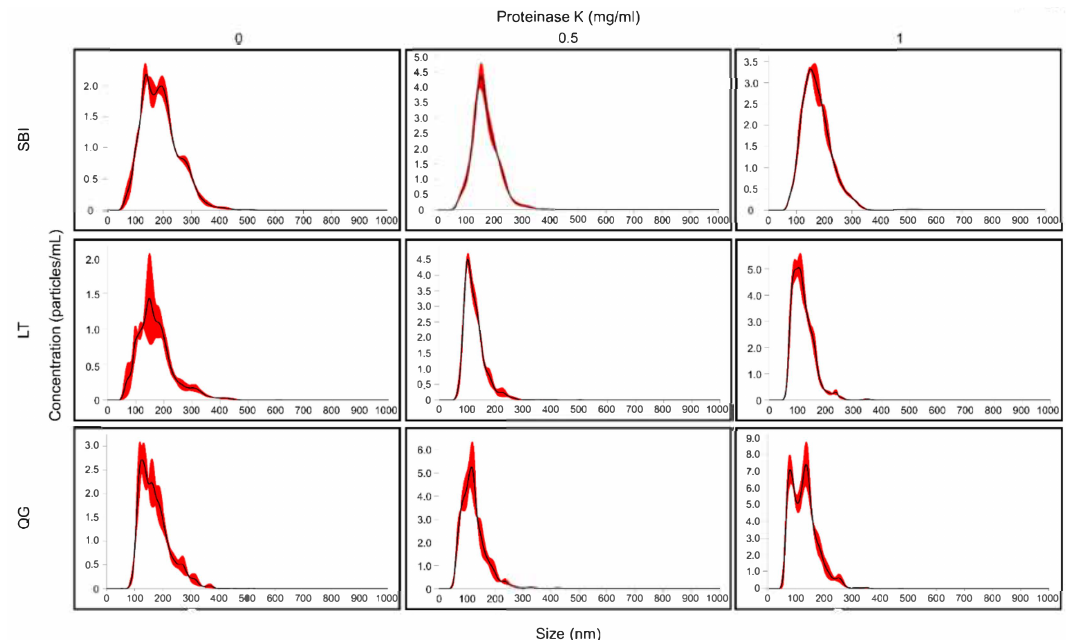
Figure 5. Size distribution and quantification analysis of ELV preparation by nanoparticle tracking analysis (NTA). The number of particles ( × 10 7 ) per mL and size distribution for each preparation (1:500 dilution) is shown. The calculated size distribution of particles is depicted as a mean (black line) with standard error (red shaded